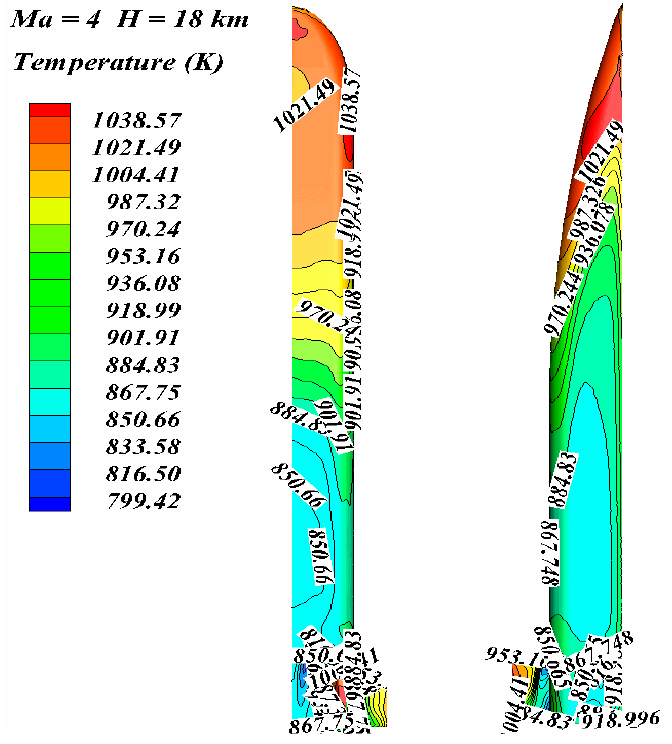
Figure 5. Isothermal distribution of leeward side at Ma 4.